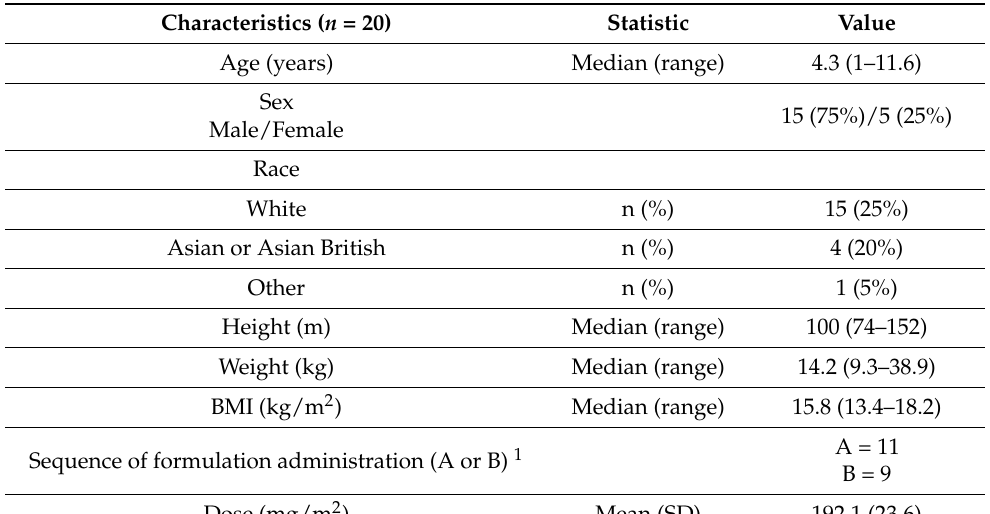
Table 1. Demographics of the study